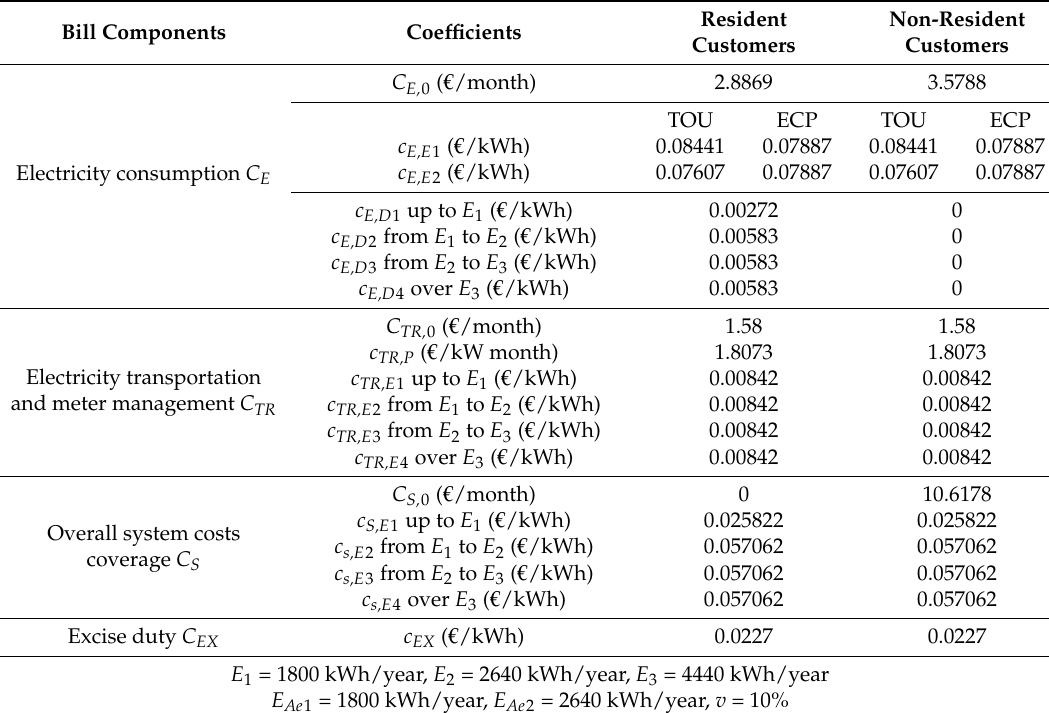
Table 4. Coefficients for the computation of the customer bill (values are defined by the Italian national authority and are updated to the third quarter of